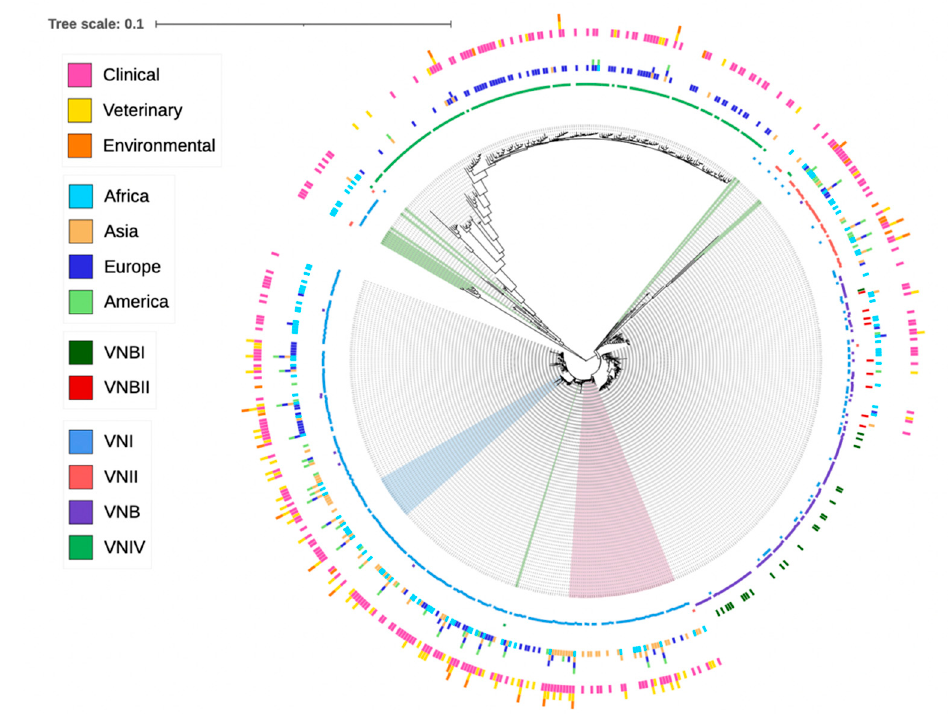
Figure 1. Phylogenic tree showing the relationships among 657 sequence types (ST) of the C. neoformans species complex. A total of 3 large circles and 10 small circles were used to display the metadata associated with each ST. The outermost large circle containing three small circles shows ecological niches, with each colored bar corresponding to one ecological niche. The middle large circle containing four small circles shows the continental distributions of each ST, with each colored bar corresponding to one continent. The next circle inside containing two colored bars corresponds to strains that were identified as VNBI (green) and VNBII (red) by authors who reported these STs. The next four small circles correspond to four original molecular types (VNI, VNII, VNB and VNIV) assigned for each ST, with each small circle corresponding to one molecular type and the presence of the ST in the molecular type indicated by a colored bar stick. Legends on the left indicate the correspondence between each color and the metadata of each ST. STs shaded in green are those showing significant deviations from their original four main molecular type assignments. STs shaded in pink and blue correspond to those closely related to ST5 and ST93, respectively, which were separately analyzed for evidence of recombination. Table 4. Allelic profiles of STs with intermediate and inconsistent molecular type assignments be- tween the original assignments in the MLST database and those based on the seven-gene phylogeny in Figure 1. Fifteen STs with mixed background colors are likely hybrids of serotypes A and D.